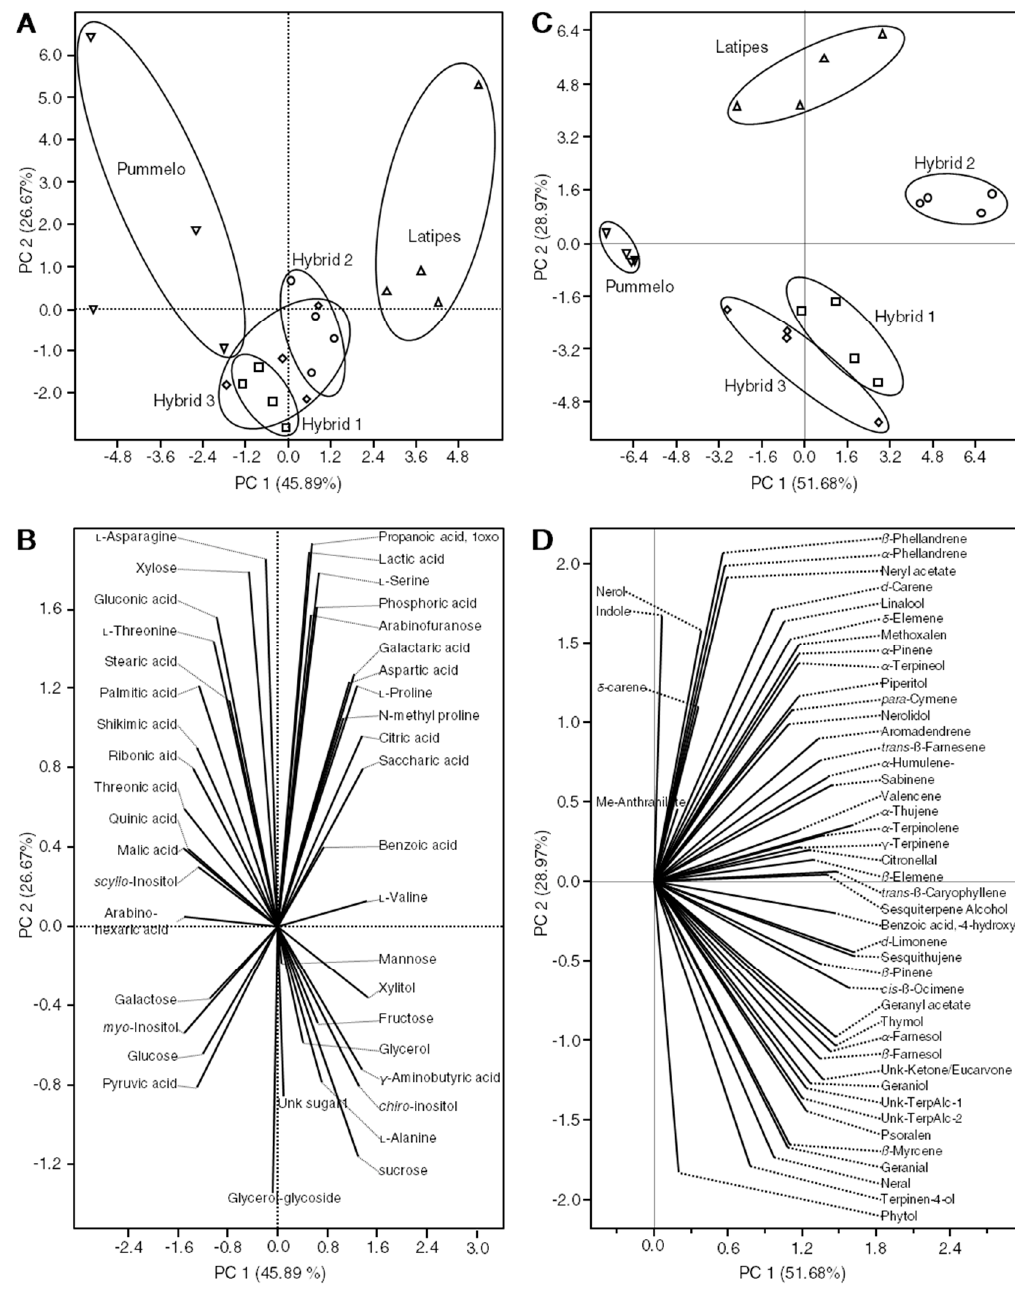
Figure 2. Principal components analysis and its associated loading plot for polar and volatile metabolites in three different hybrids and their parents using GC-MS ( n = 4). ( A ) Principal components analysis and its associated loading plot ( B ), using the concentration of all detected leaf non-volatile metabolites. ( C ) Principal components analysis and its associated loading plot ( D ) using the concentration of all detected leaf volatile (hexane extract) metabolites. In panels ( A , C ), upward-facing triangles represent C. latipes , downward-facing triangles represent C. maxima (Pummelo), squares represent hybrid 1, circles signify hybrid 2, and rhombuses represent hybrid 3.